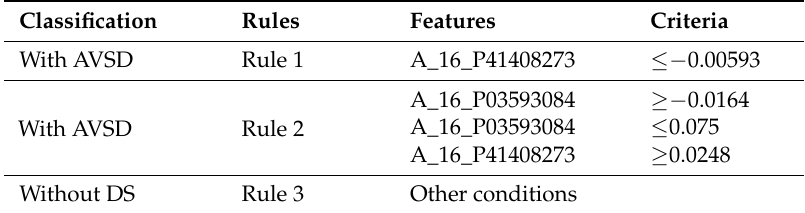
Table 2. Three decision rules extracted from the informative